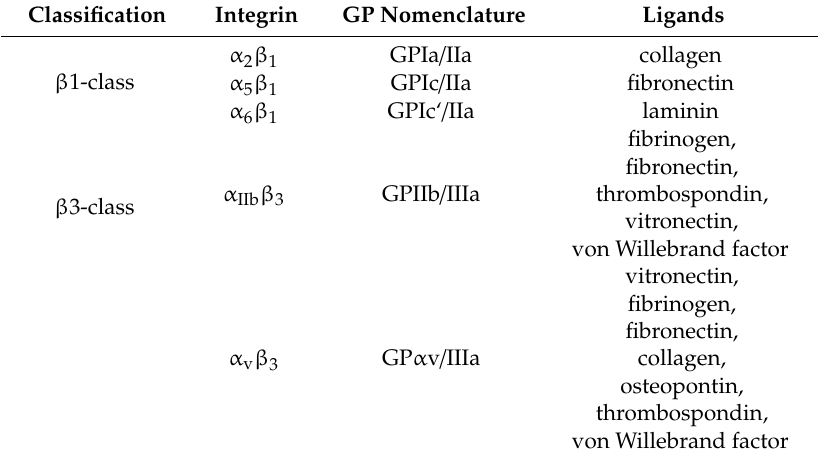
Table 1. Platelet integrins with classification, glycoprotein (GP) nomenclature and corresponding